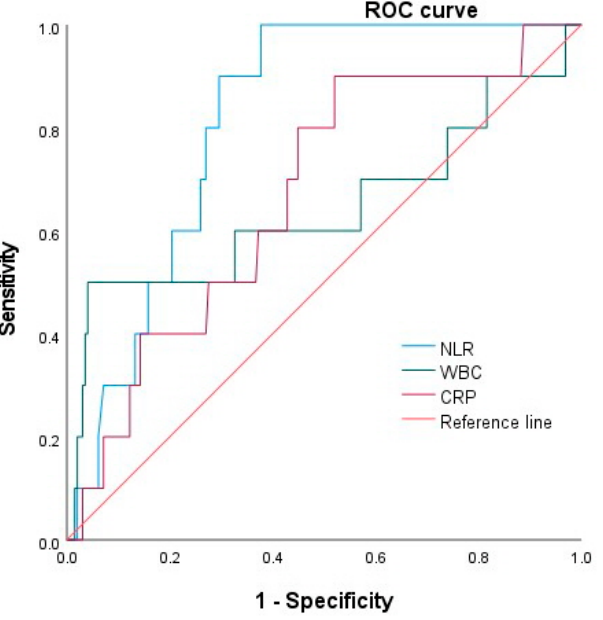
Figure 3. Receiver operating characteristic curves for NLR, WBC and CRP as predictors of shock. NLR, neutrophil–lymphocyte ratio; WBC, white blood cell; CRP, C-reactive protein.